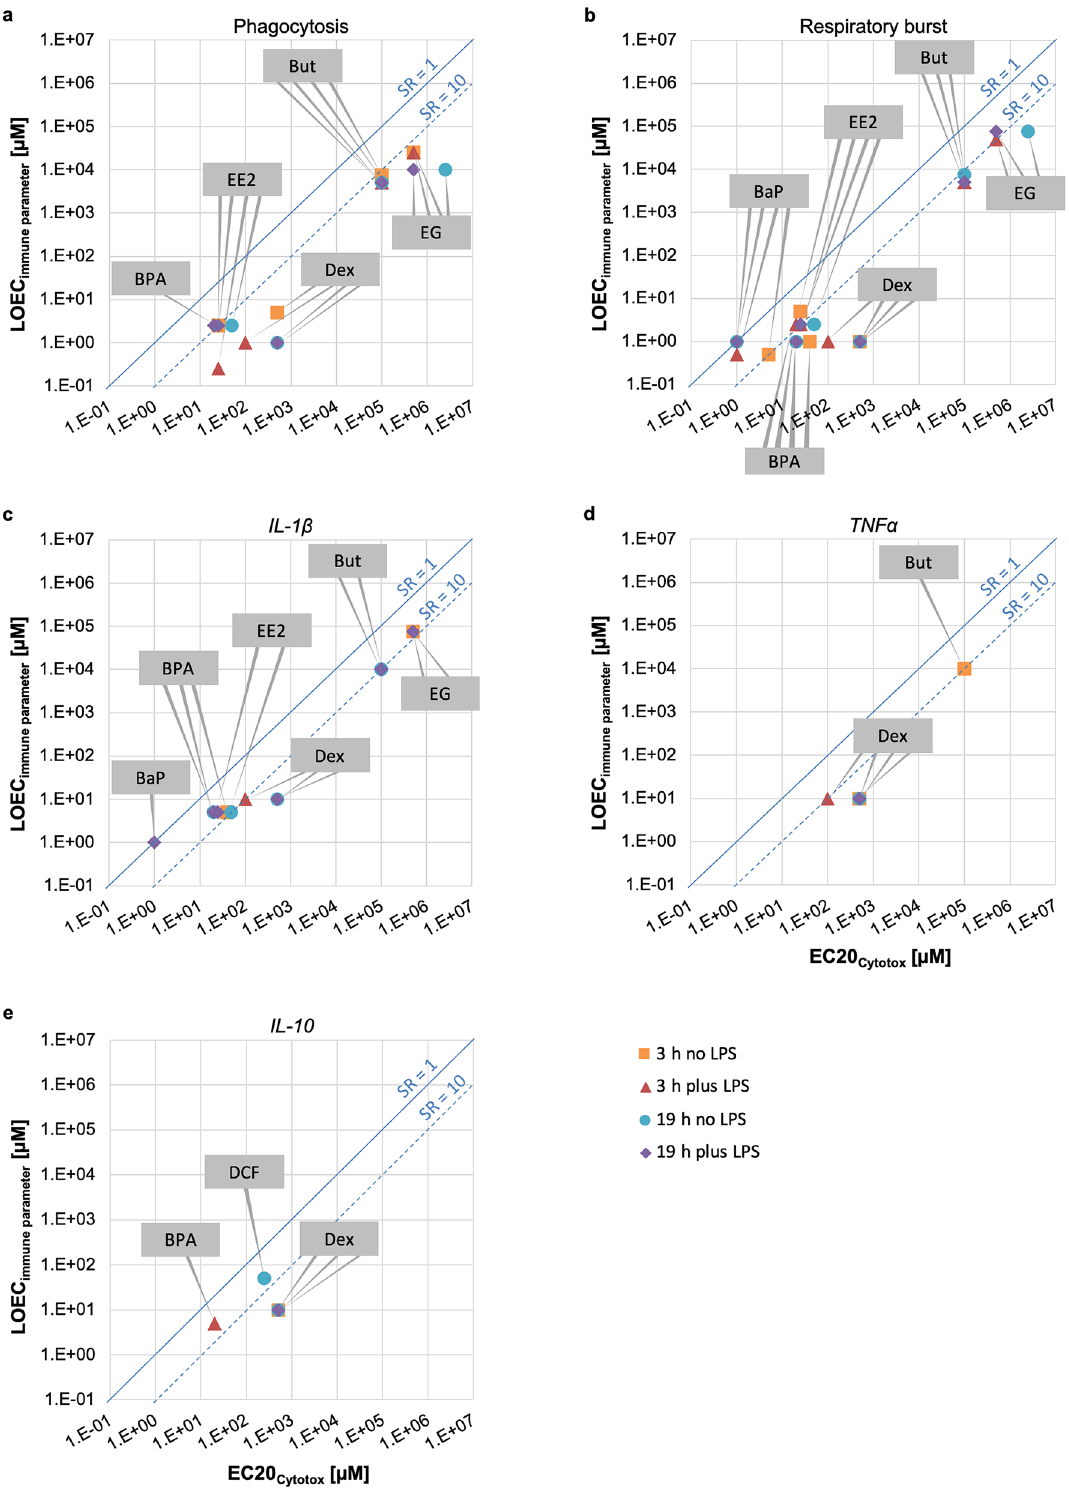
Figure 4. Comparison of the LOEC immune parameter with the experimental cytotoxicity EC20 Cytotox . The immunotoxicants are dexamethasone (Dex), diclofenac (DCF), benzo(a)pyrene (BaP), bisphenol A (BPA) and ethinylestradiol (EE2); non-immunotoxicants are ethylene glycol (EG) and butanol (But). The LOEC immune parameter was not available for all endpoints and chemicals since only chemical-induced effect on immune parameter with a p value ≤ 0.05 were considered. SR > 10 indicates specificity for chemical effects on immune parameter. SR specific ratio, LOEC lowest observed effect concentration, EC effect